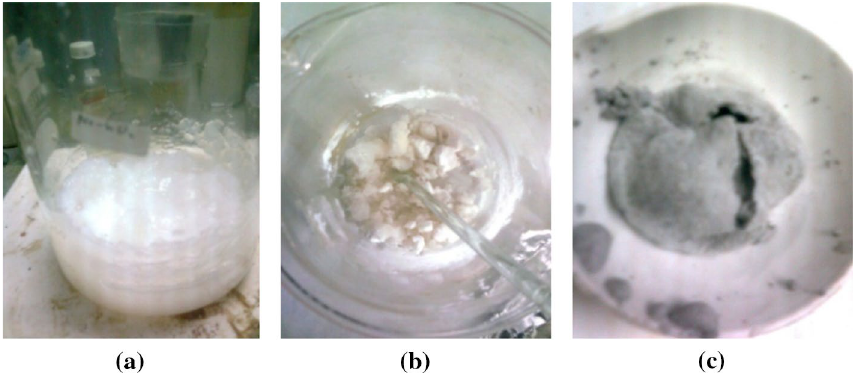
Figure 8. Gelling process after sodium silicate extraction from rice husk ash ( a ); gels used for adsorption ( b ); silica with surfactant ( c ) before